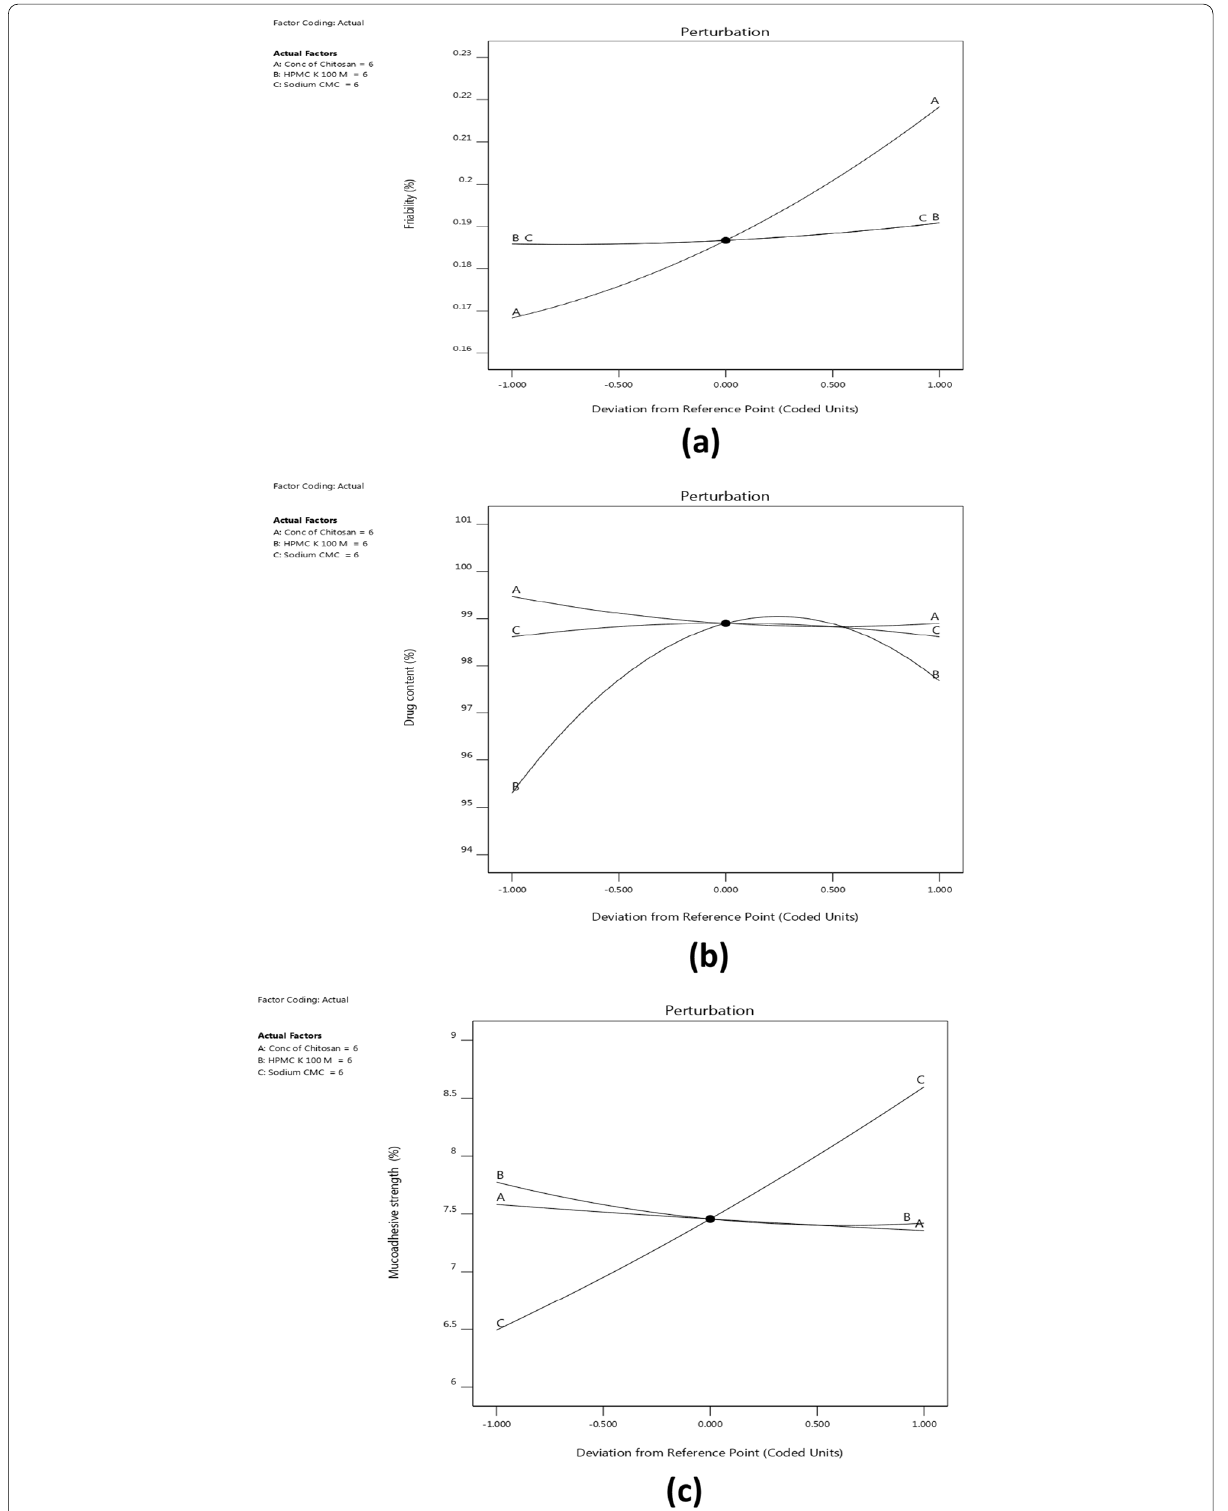
Fig. 3 Representative plot for perturbation analysis for the observed responses of R 1, R 2 and R 3 ( a – c